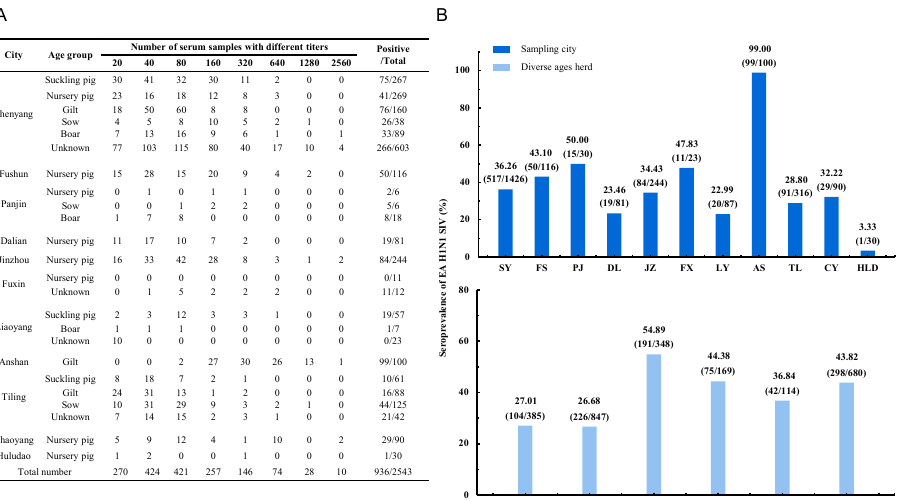
Figure 2. Seroprevalence of EA H1N1 SIVs in Liaoning province. ( A ) Sampling instructions for each city in Liaoning. ( B ). Seroprevalence of EA H1N1 SIVs in sampling cities and among herds of pigs